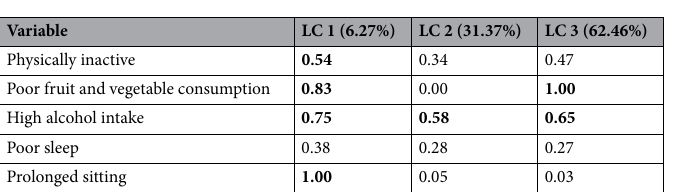
Figure 3. Lifestyle risk behaviours among UK adults with CVD risk.